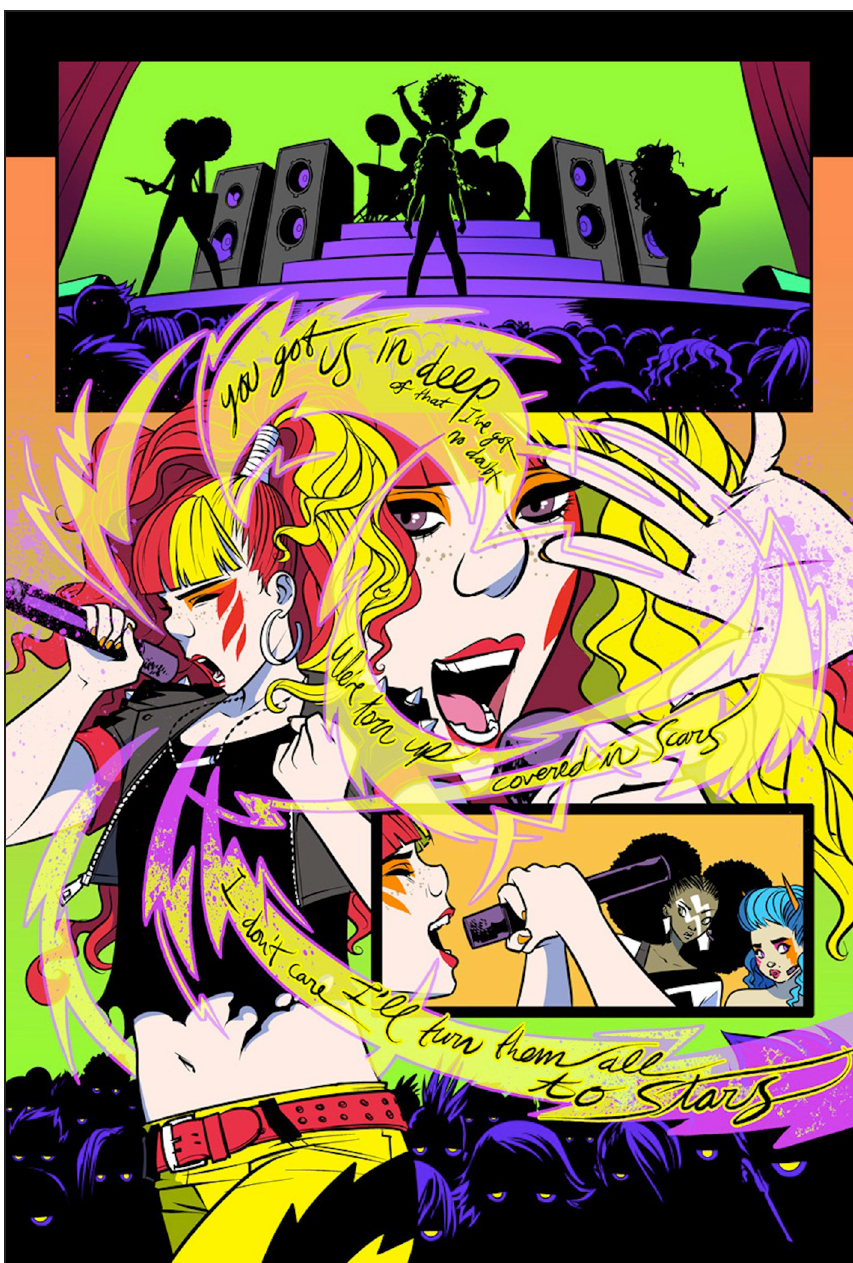
Figure 3: Blaze singing with the Misfits Dark Jem (Thompson and Campbell, 2016. © Hasbro